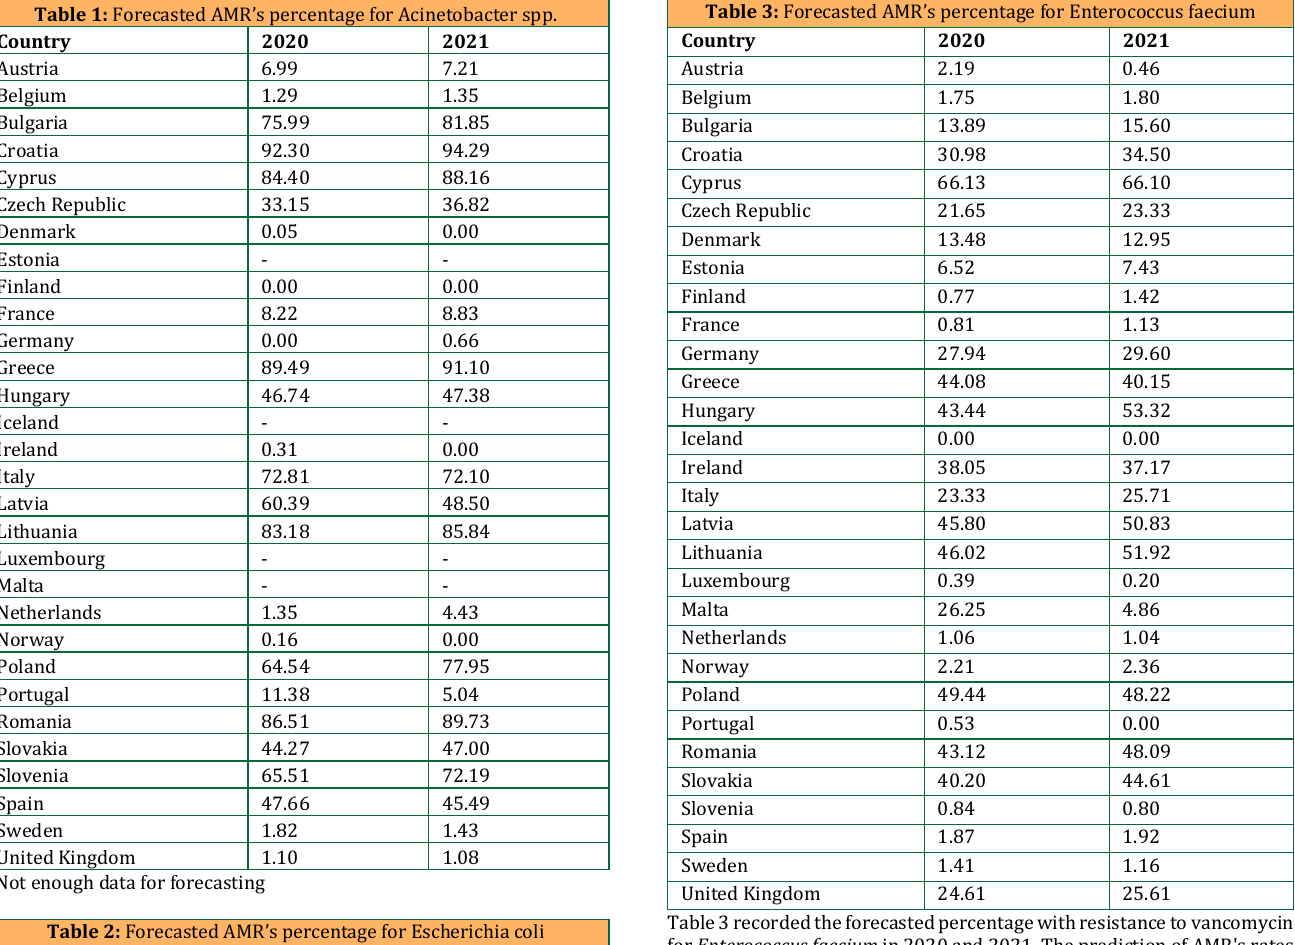
Table 3: Forecasted AMR’s percentage for Enterococcus faecium